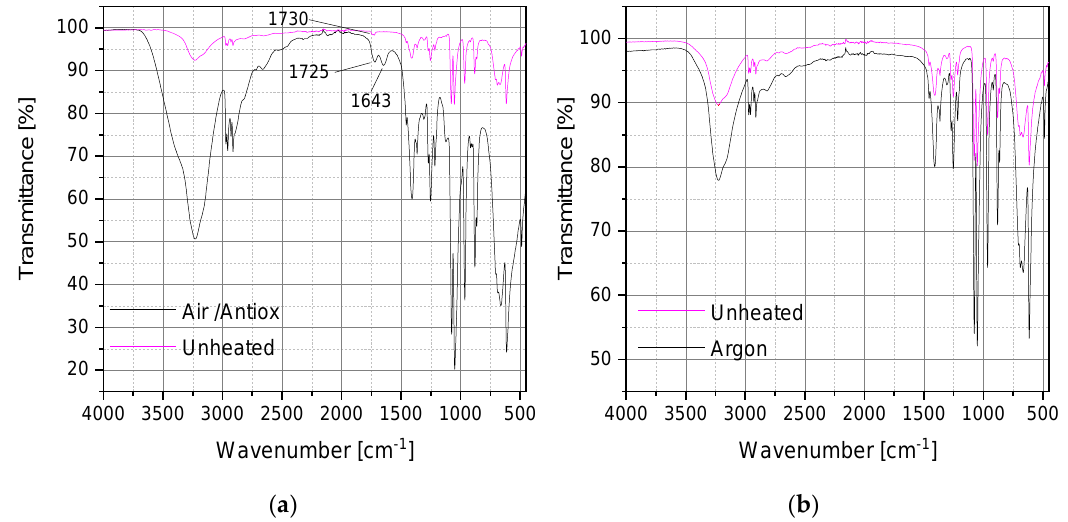
Figure 11. FT‐IR spectra of the long‐term‐tests for ( a ) erythritol with antioxidant under air; ( b ) pure erythritol under argon atmosphere.